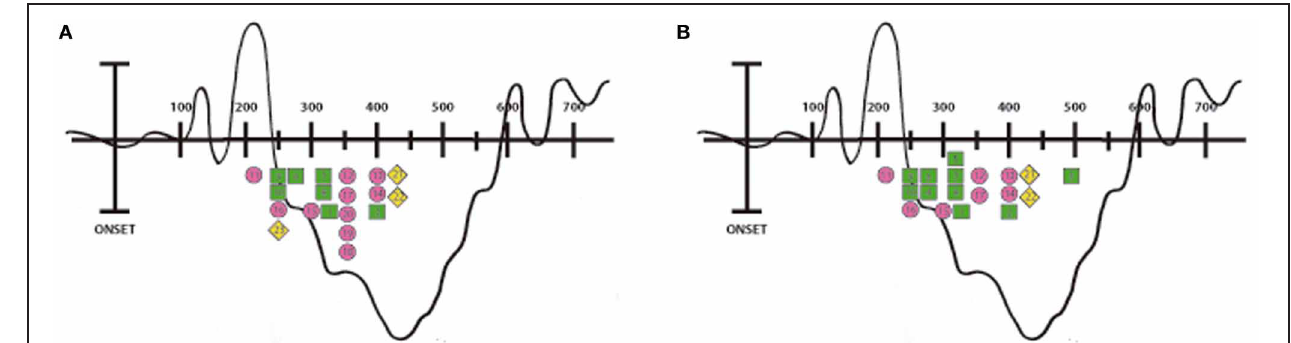
speech and co-speech gestures studies with a pink circle and current motor events studies with a yellow diamond. Picture (A) corresponds to the N400 peaks reported in the left hemisphere and picture (B) corresponds to those reported in the right hemisphere.